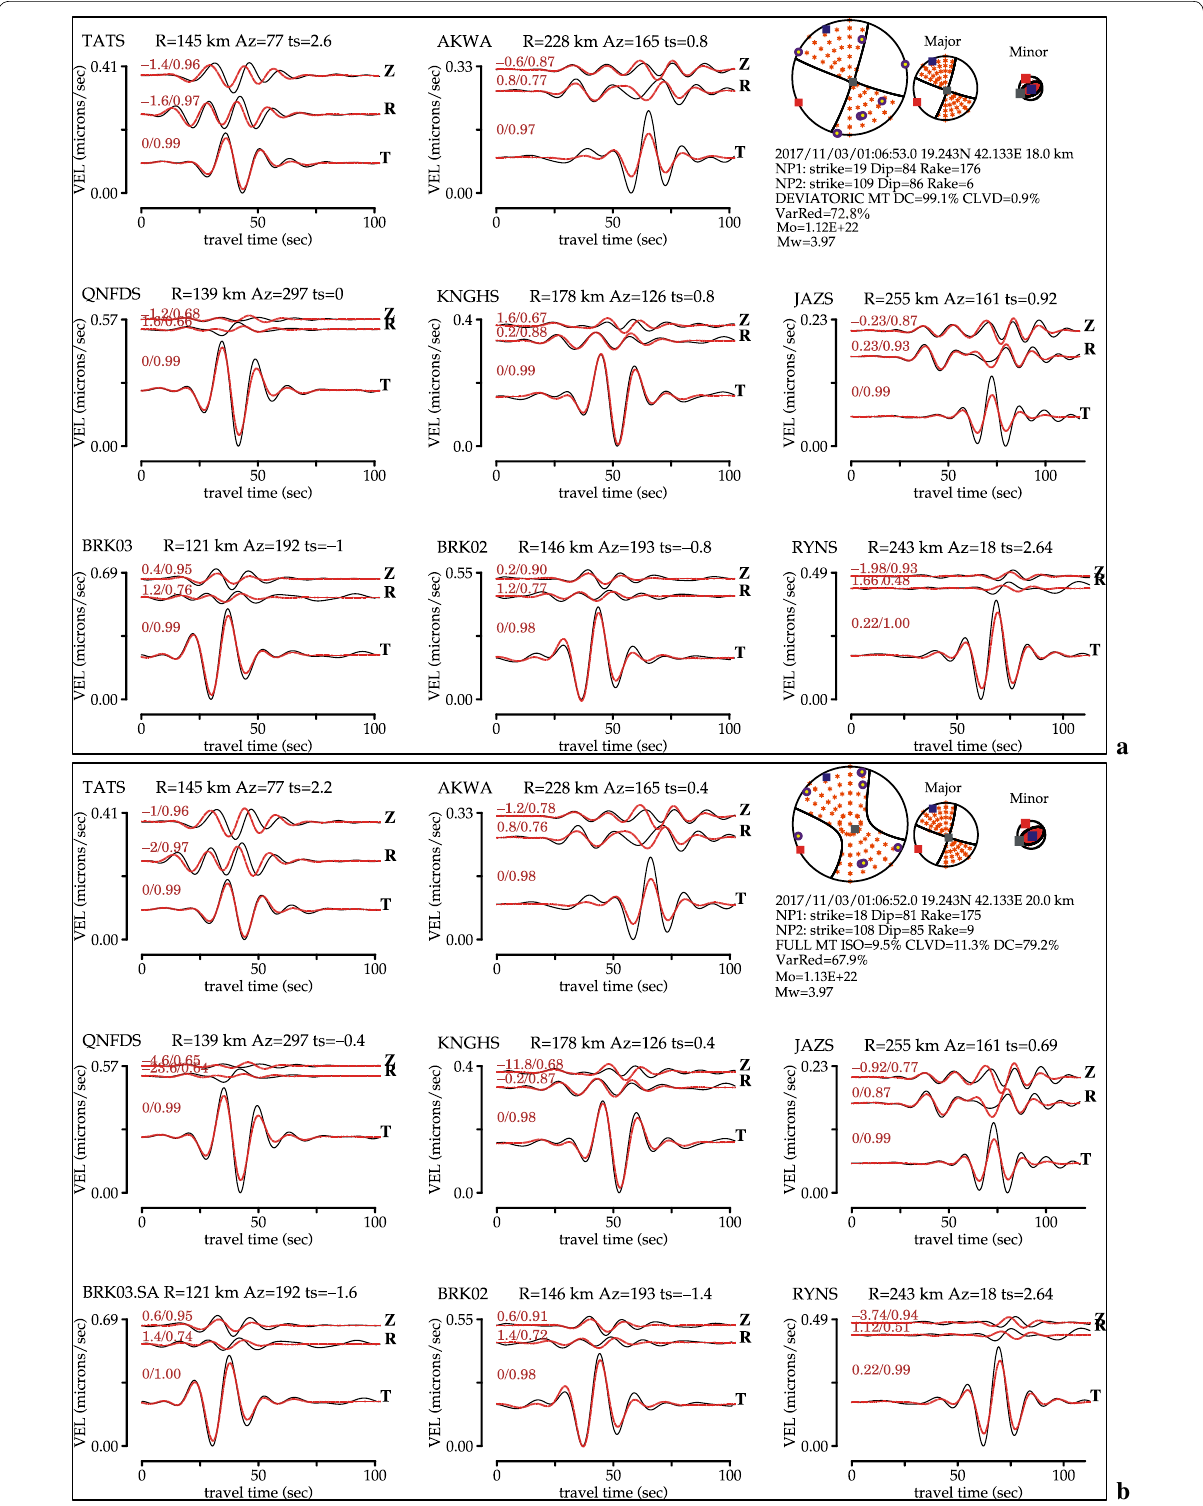
Fig. 6 Comparison between the observed (black lines) and the synthetic velocity waveforms for the optimum solutions obtained from the regional waveform inversion a the deviatoric moment‑tensor solution using the velocity model of Rodgers et al. (1999) and b the full moment‑tensor solution using the velocity model of Rodgers et al.